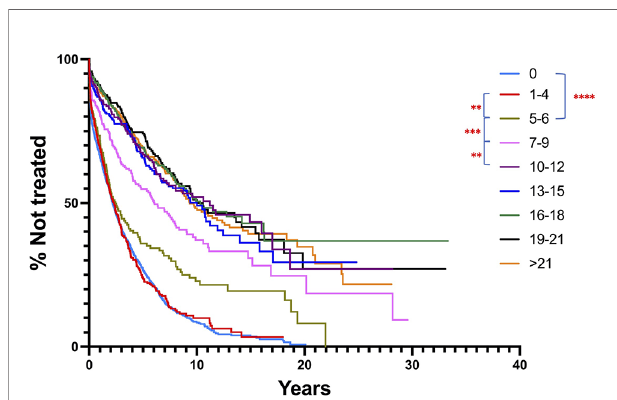
FIGURE 6 | Comparison of TTFT for patients based on IGHV nucleotide mutation number intervals, regardless of mutation type. All patients with ≥ 1 mutation per IGHV sequence were segregated into nucleotide mutation number ranges, and then TTFT compared without using a 2% cutoff. Patients bearing clones without any IGHV mutations are provided for comparison. TTFT and numbers of patients in the various intervals: 1-4: median TTFT - 2.19 yrs, n = 389; 5-6: median TTFT - 2.43 yrs, n = 173; 7-9: median TTFT - 6.06 yrs, n = 232; 10-12: median TTFT - 11.21 yrs, n = 221; 13-15: median TTFT - 10 yrs, n = 257; 16-18: median TTFT - 10.33 yrs, n = 297; 19-21: median TTFT - 10.58 yrs, n = 240; >21: median TTFT - 9.36 yrs, n = 539. ** < 0.01; *** <